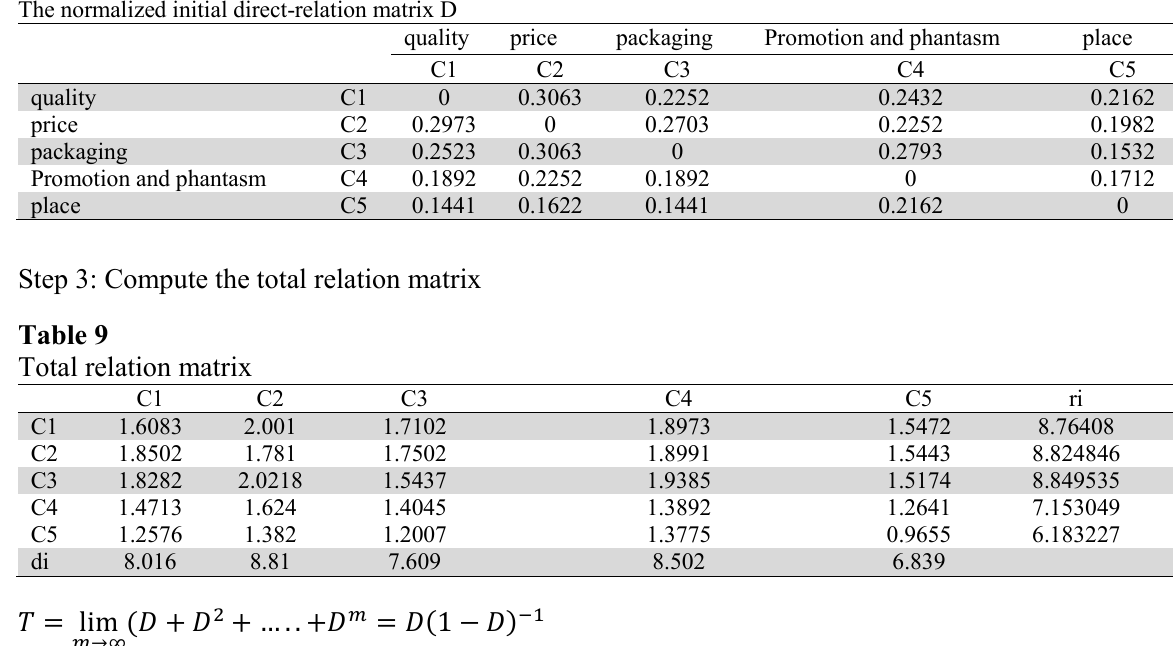
The normalized initial direct-relation matrix D